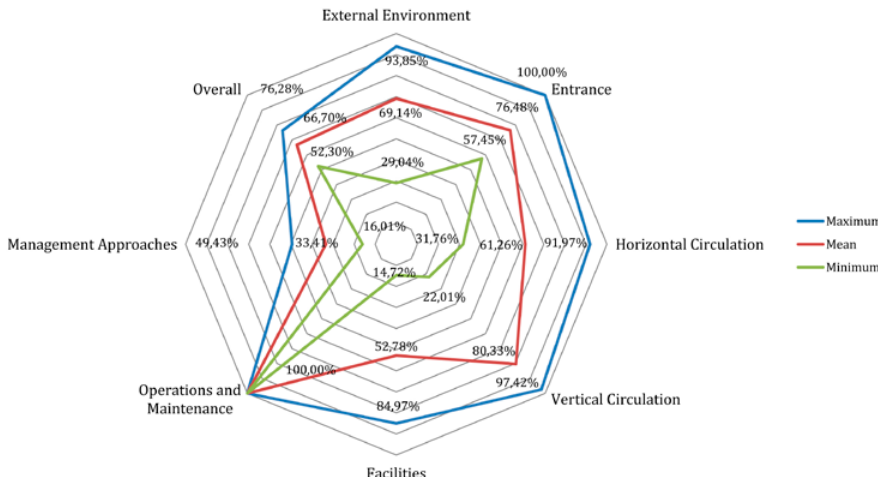
Fig. 4. Radar diagram showing the percentage of PDIS categories scored in the sampled buildings